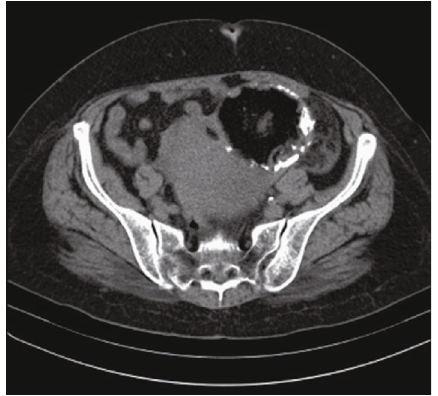
Figure 1: Preoperative CT scan.